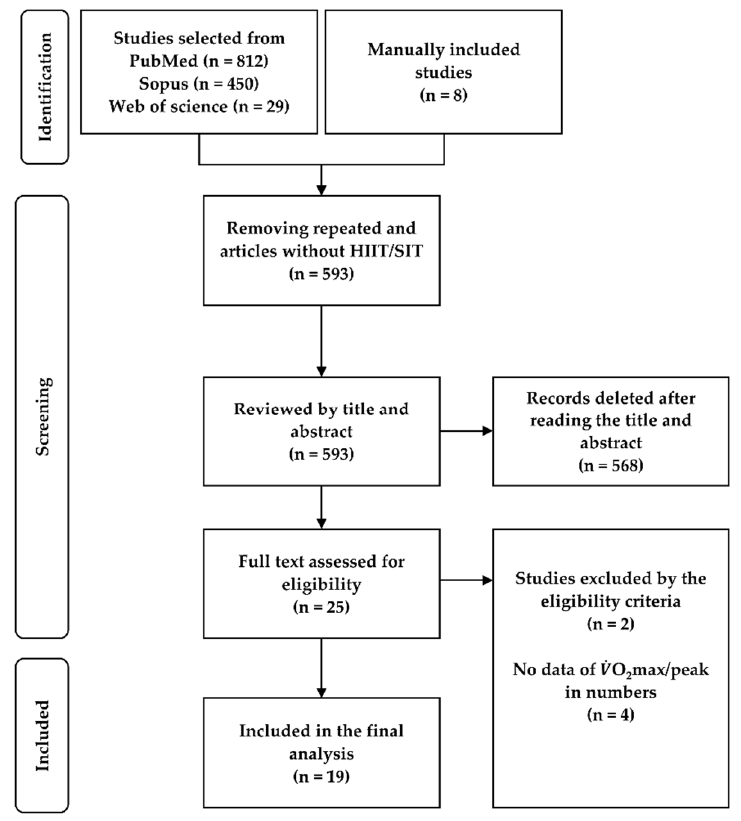
Figure 1. Flowchart of the studies included. The characteristics of the studies included are detailed in Table